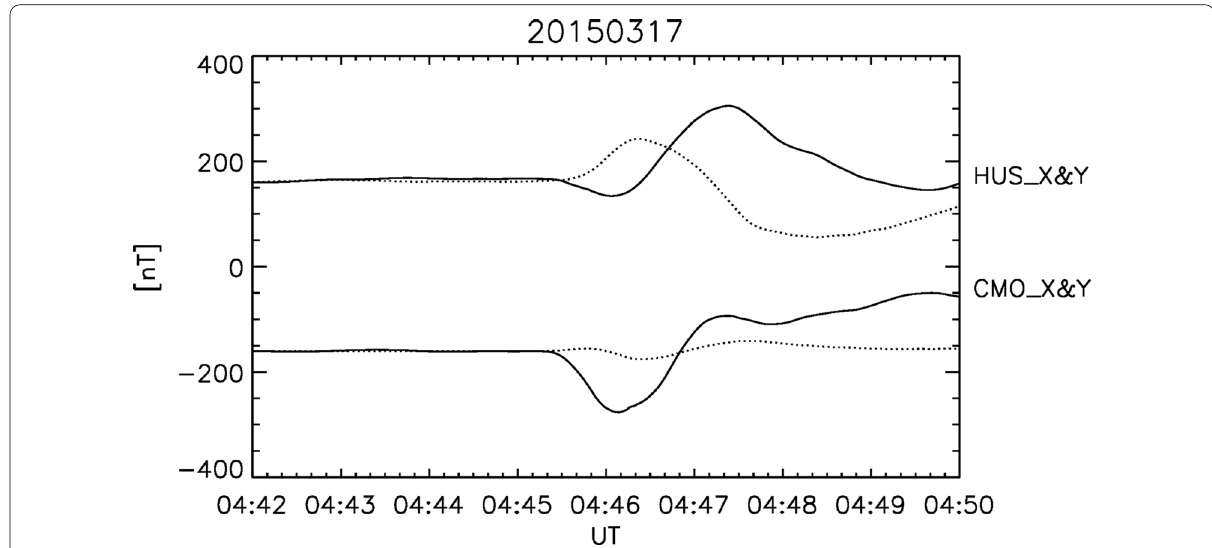
Fig. 4 SCs recorded in the X- and Y-components at Husafell, Iceland (HUS) and College, Alaska (CMO), located in the pre-dawn (0410 MLT) and afternoon (1730 MLT), respectively. The X and Y are plotted with the solid and dotted curves, respectively